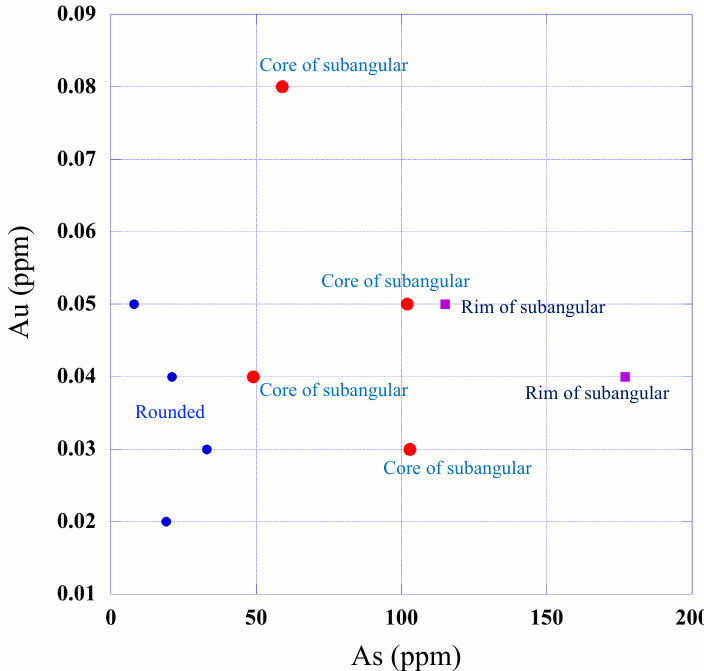
Figure 7. Relationship between Au and As concentrations (ppm) in pyrite from the South Deep deposit (an area of lower Au and As concentrations of Figure 6). The analysis position (rim or core) and the shape of the pyrite are given near the symbol. Violet and red symbols represent data collected at the rim and core of subangular grains, respectively. Rounded grains are shown in blue.